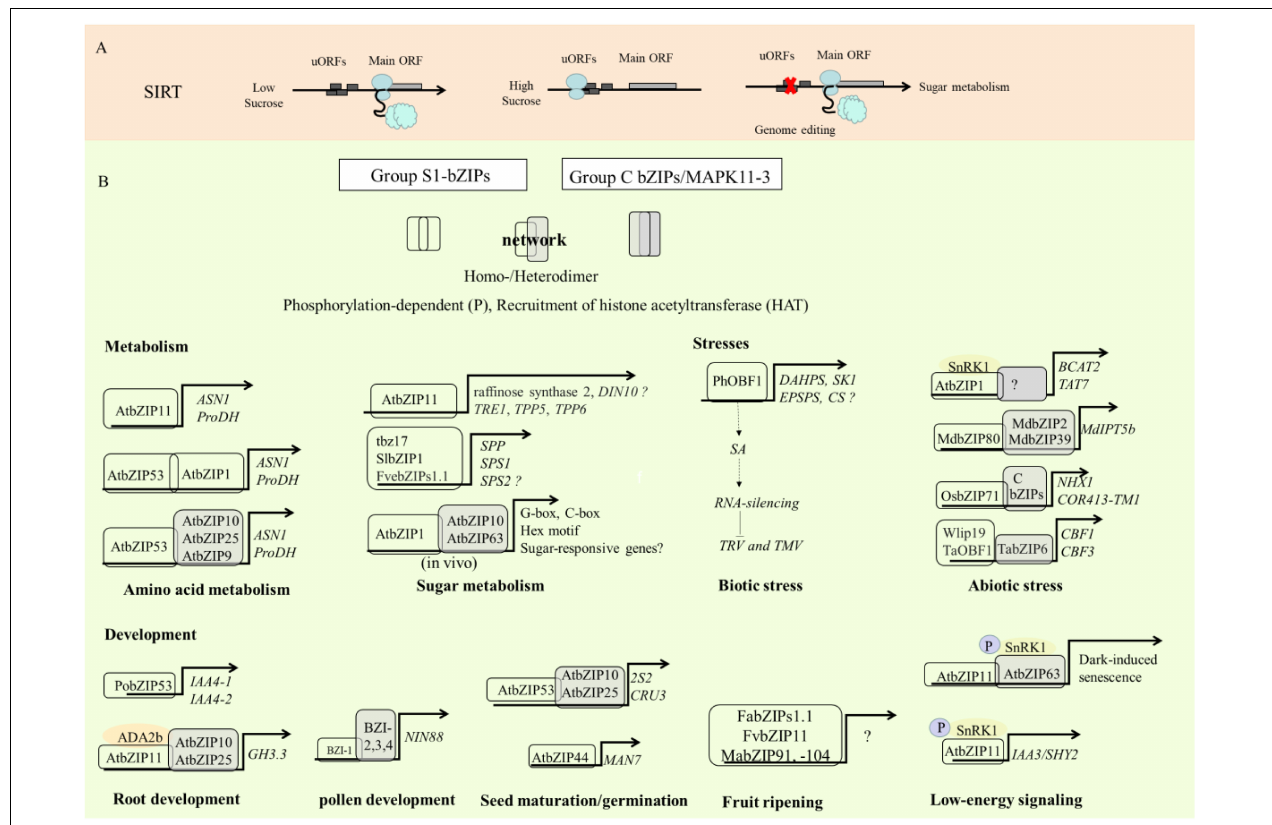
FIGURE 3 | Multiple levels of regulation and biological function of S1-bZIPs. (A) Translation regulation of S1-bZIPs by SIRT. SIRT: Sucrose-induced repression of translation. (B) Biological function and target genes regulated by S1-bZIP. The regulated target genes by S1-bZIP (white) or heterodimers of S1-bZIPs and C-bZIPs (gray). Gene names: ASN1 , ASPARAGINE SYNTHETASE 1 ; ProDH , Proline Dehydrogenase ; TRE1 , Trehalase 1 ; TPP5/-6 , trehalose-phosphate phosphatase 5 /- 6 ; SPP , sucrose-phosphatase ; SPS1/-2 , sucrose-phosphate synthase 1/-2 ; HXK1 , hexokinase 1 ; DAHPS , 3-Deoxy-D-arabino-heptulosonate 7-phosphate synthase ; SK1 , shikimate kinase 1 ; EPSPS , 5-enolpyruvylshikimate 3-phosphate synthase ; CS , chorismate synthase ; BCAT2, BRANCHED-CHAIN AMINO ACID TRANSAMINASE2; TAT7 , TYROSINE AMINOTRANSFERA- SE7; IPT5b , Isopentenyltransferase 5b ; NHX1 , Na+/H+exchanger 1 ; COR413-TM1 , cold acclimation protein; CBF1 /- 3 , C-repeat/DRE binding factor 1 /- 3 ; ADA2b: transcriptional adapter ADA2b; IAA4-1/4-2/-3 , INDOL-3-ACETIC ACID INDUCIBLE 4-1/4-2/-3 ; SHY2 , SHORT HYPOCOTYL 2 ; GH3.3 , Indole-3-acetic acid-amido synthetase ; NIN88 , Defective invertase ; 2S2 , SEED STORAGE ALBUMIN ; CRU3 , CRUCIFERIN 3; MAN7 , endo-beta-mannase 7 ; P,